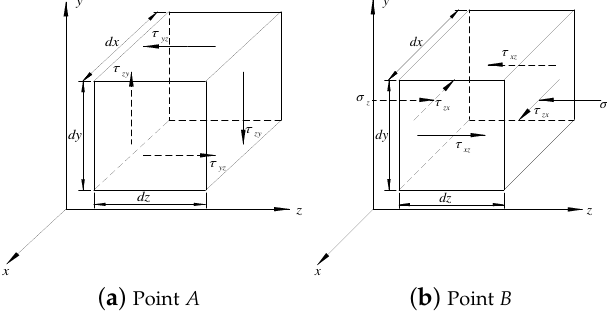
Figure 4. Stress regimes of the element.